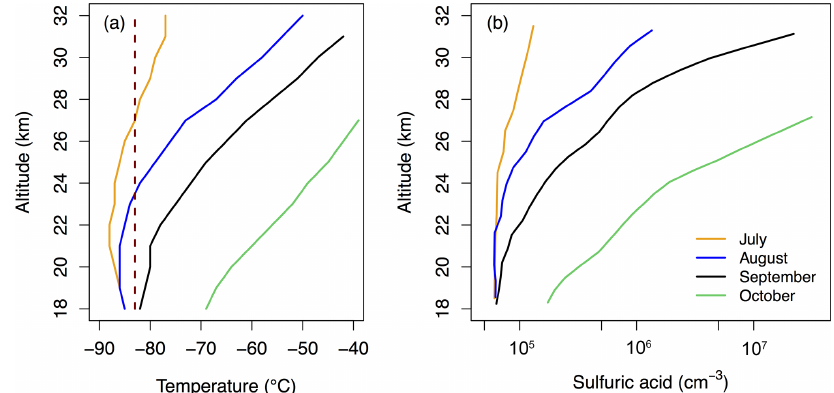
Figure 1. Temperatures (a) during Antarctic winter above McMurdo Station, Antarctica (78 ◦ S), as presented in Campbell and Deshler (2014). The dashed line shows the lower temperature limit for which the SAWNUC model is valid and at which lower temperatures were kept fixed. In (b) , corresponding sulfuric acid profiles are shown that lead to a 10% CN increase by nucleation and growth to observable size during 1 month. For these nucleation threshold profiles , we assume a monodisperse CN background of 10cm − 3 with 100nm diameter at all altitudes (18–32km) for every month